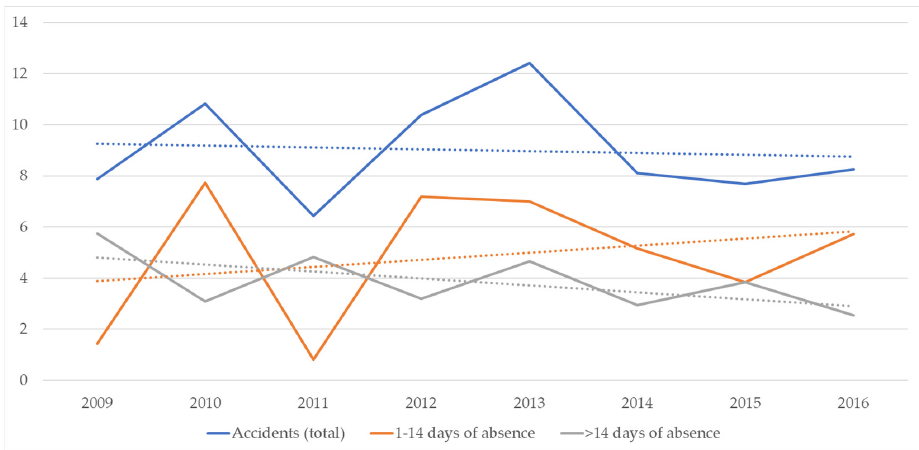
Figure 7. Incidence rates in construction of bridges and tunnels. Based on data from [17 – 24,27] .